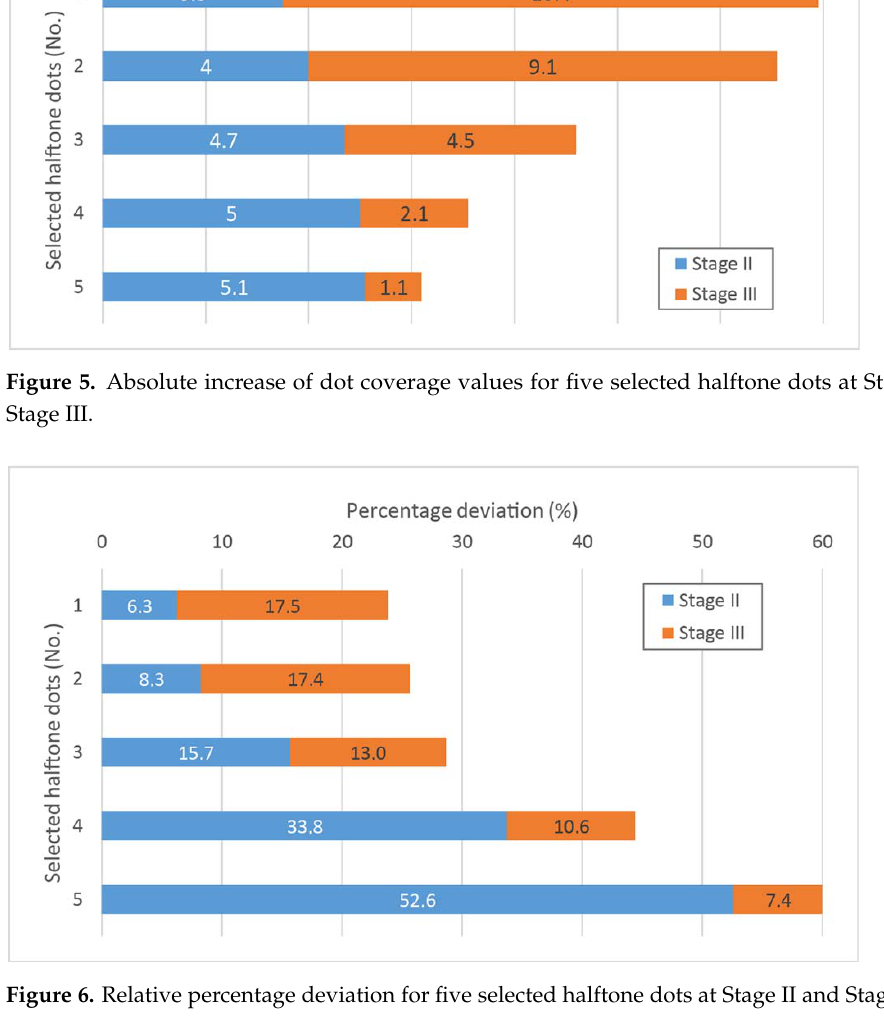
Figure 6. Relative percentage deviation for five selected halftone dots at Stage II and Stage III.